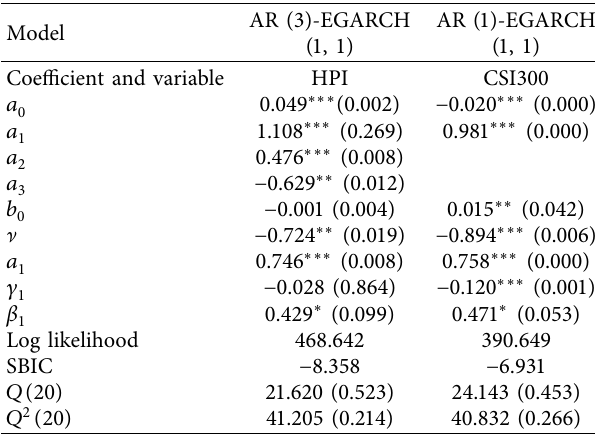
Table 2: Results of the AR-EGARCH model. Table 1: Results of basic statistic